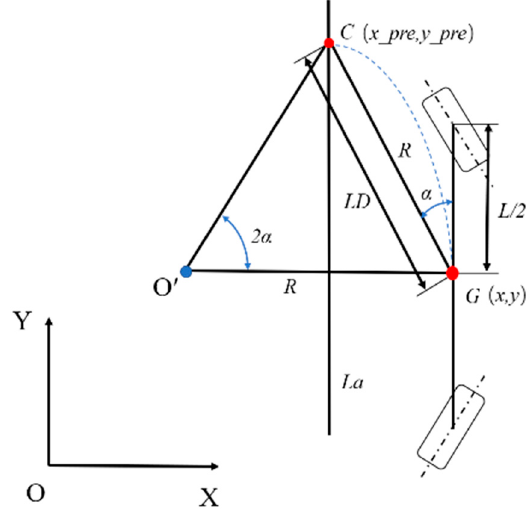
Figure 3. Framework diagram of traditional pure tracking algorithm.